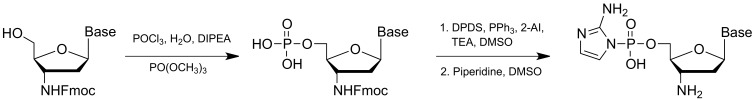
3′-NH2-2AIpddA/G/T synthesis.